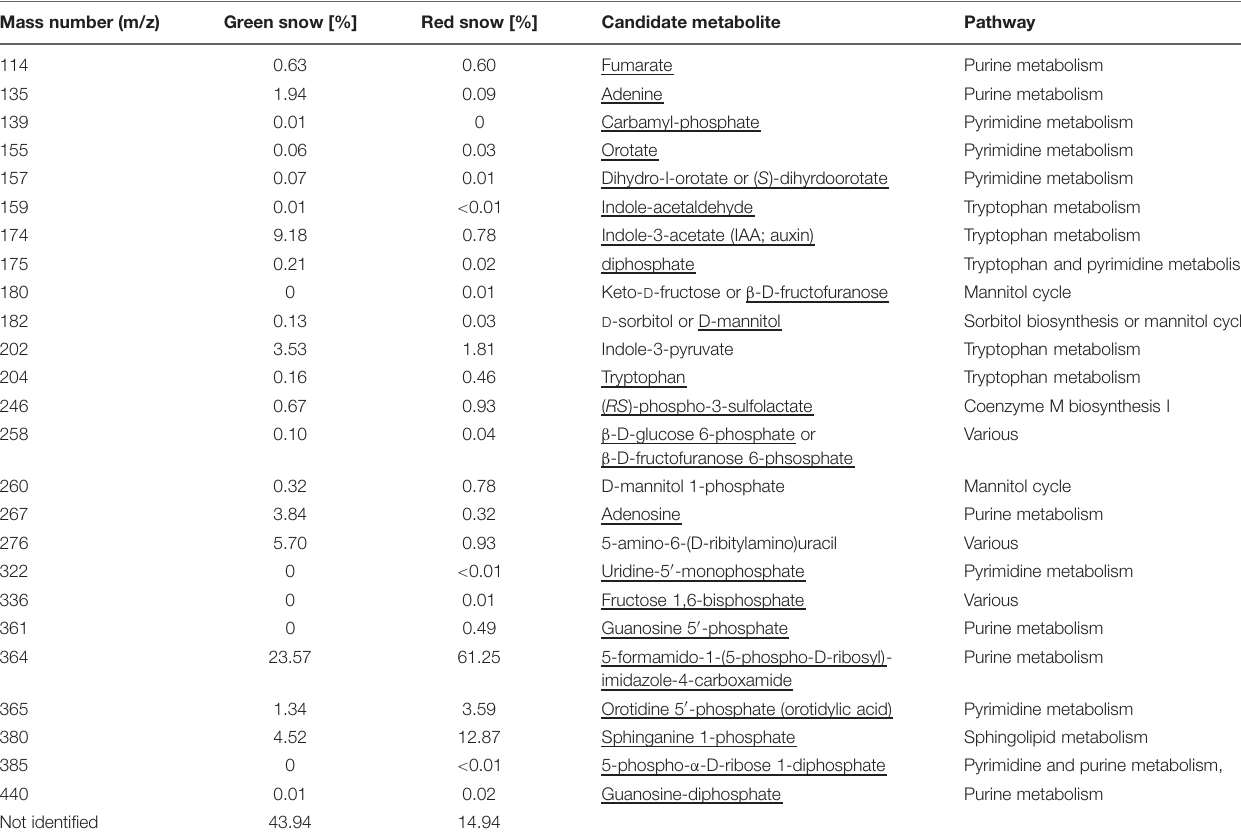
TABLE 4 | Main metabolic compounds with mass numbers, their abundance relative to the total metabolites ingreen and red snow, and candidate metabolites and pathways corresponding to the mass numbers.